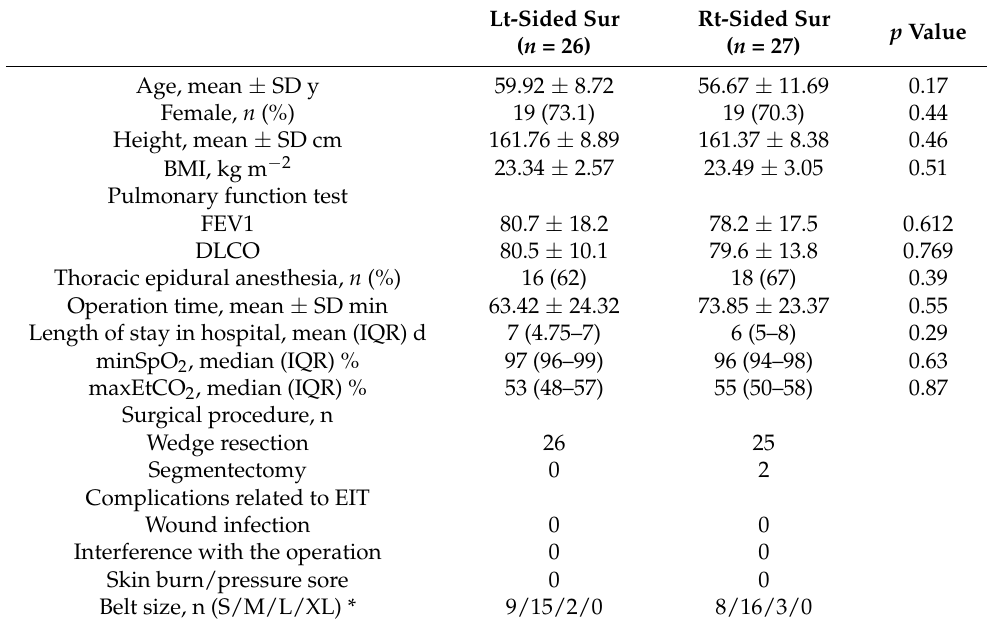
Table 2. Patient Characteristics.